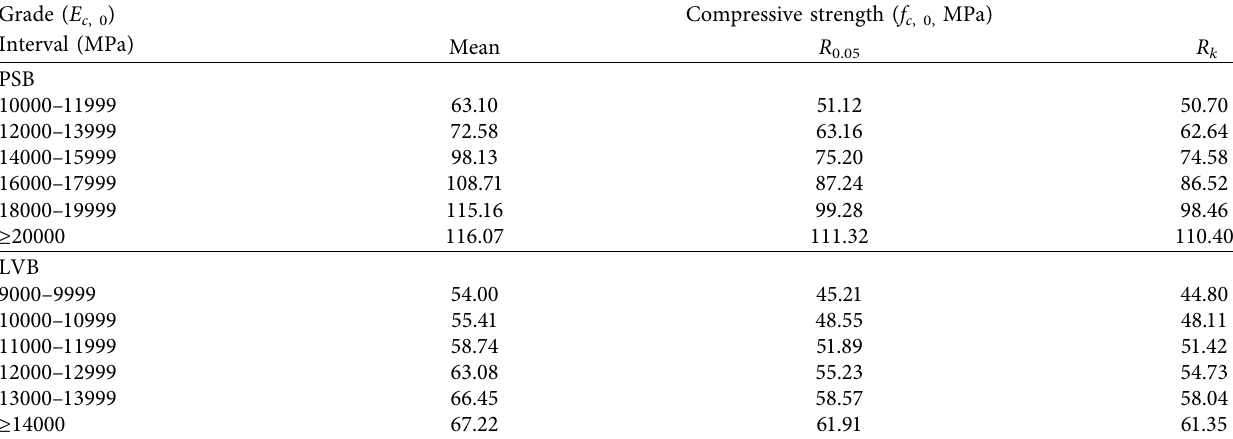
Figure 7: Compressive strength grading of EBC: based on compressive modulus for PSB (a); based on compressive modulus for LVB (b); based on density for PSB (c); based on density for LVB (d). Table 8: Compressive strength grade classification of EBC based on compressive modulus.